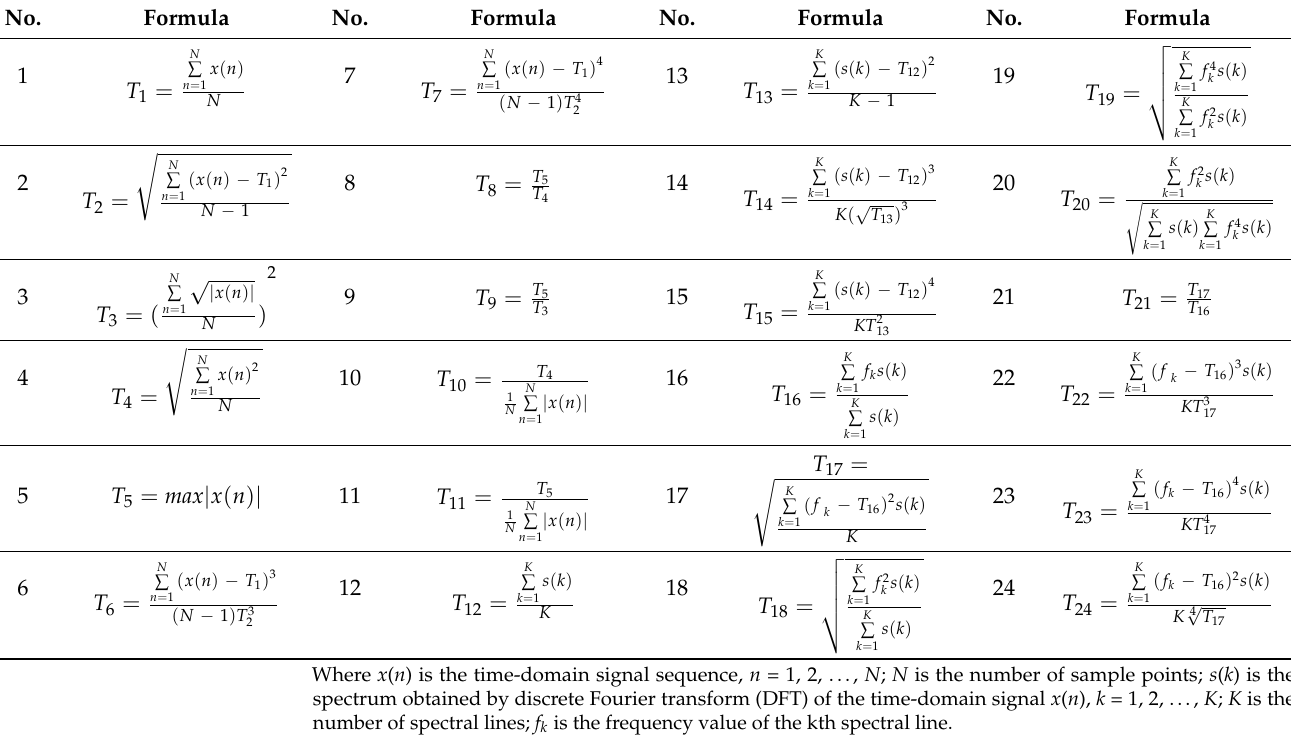
Table 1. Multi-domain feature